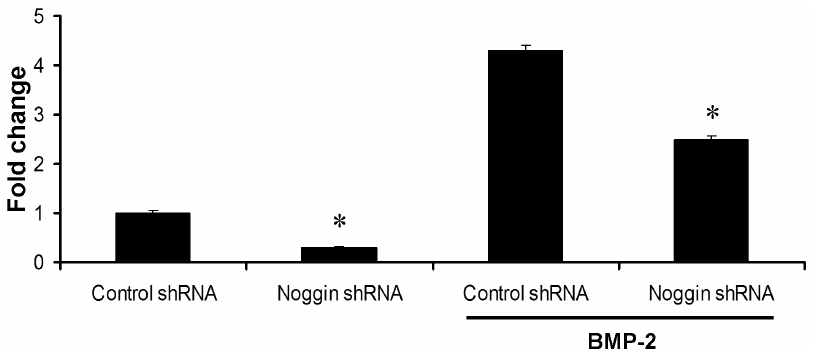
Figure 1. Expressional noggin gene in ASCs transduced with noggin shRNA lentiviral particles. Noggin expression was downregulated in ASCs transduced with lentivirus particles targeting noggin shRNA in the presence or absence of BMP-2 (100 ng/ml) as evaluated by quantitative real-